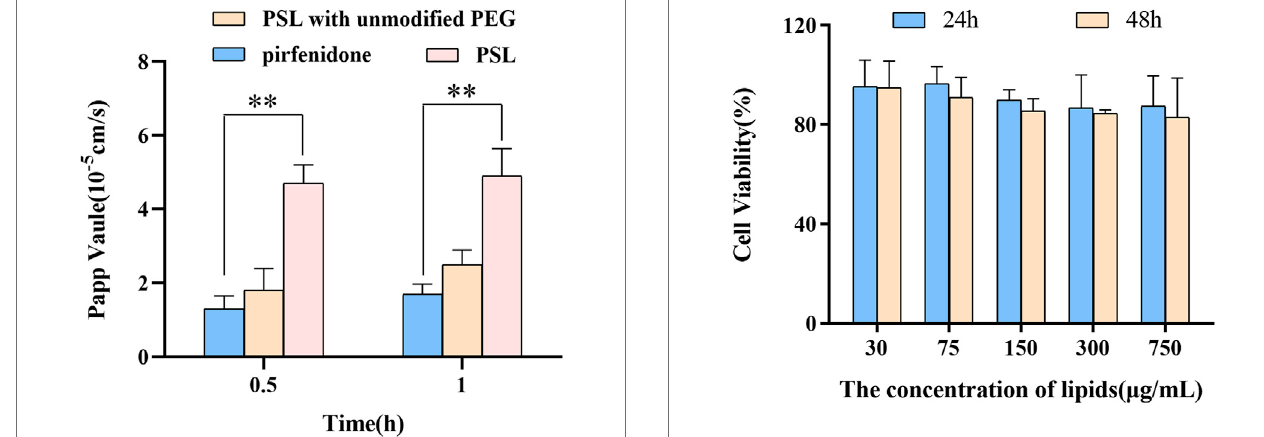
FIGURE5| In fl uenceofblankPSLsontheviabilityofWI-38cellsafter24 and 48 h (blank PSLs: pH-sensitive liposomes without pirfenidone, WI-38 cells: The human embryonic lung fi broblast cell line. n = 3).